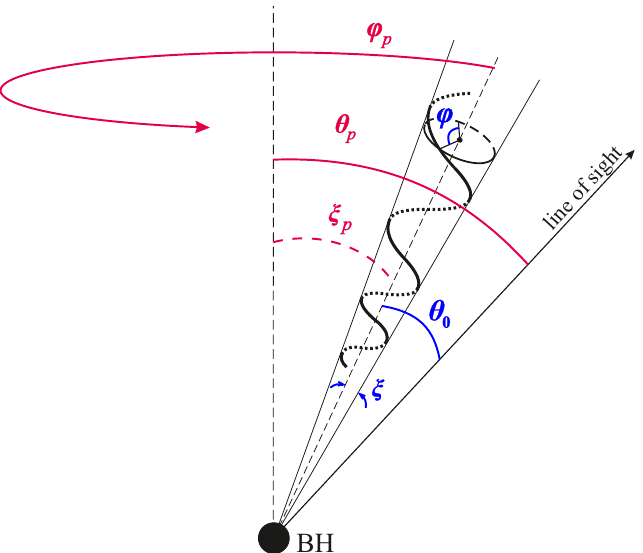
Figure 8. A sketch of the helical jet precession: the blue color marks geometrical parameters of the helical jet, which is originated by development of the Kelvin–Helmholtz instability. The red color marks geometrical parameters of the precession of the helix axis under the assumption of a single supermassive black hole being in the center of OJ 287. Table 3. Used observational data [14,42] and obtained values of the angle between the cone axis and the line of sight θ 0 : the columns contain (1) mean data of 12-year flares; (2) maximum flux density of the flare; (3) mean minimum flux density after the corresponding flare; and (4) obtained values for θ 0 .